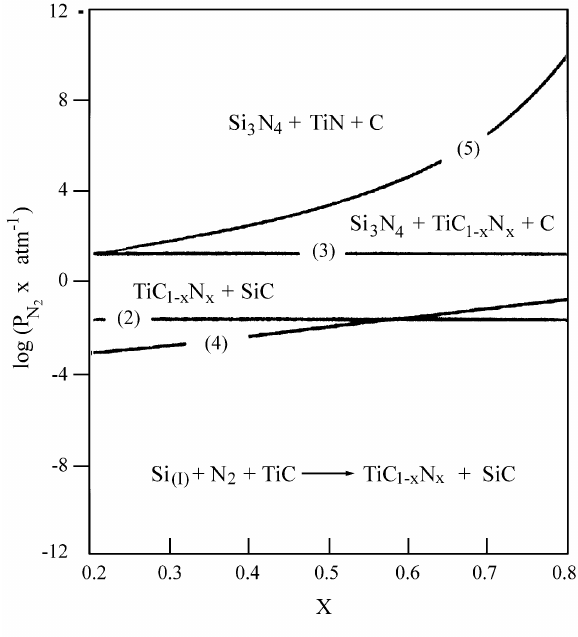
Figure 1. Thermodynamic stability of TiC-Si 3 N 4 at 1500 °C. Figure 2. Thermodynamic stability of TiC-Si 3 N 4 at 1750